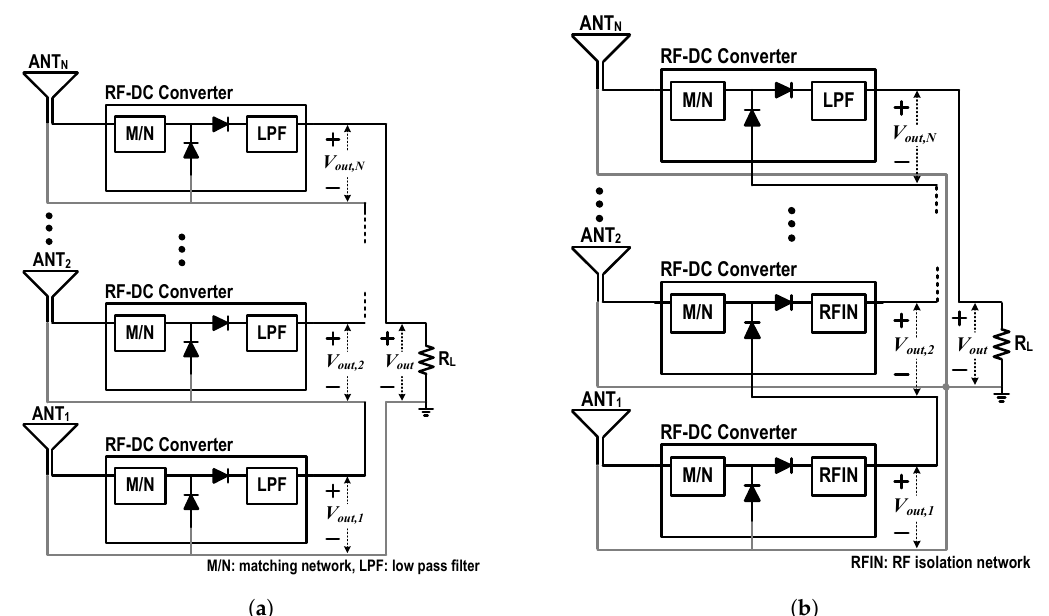
Schematics of the voltage combined N-stack RF–DC converters, ( a ) conventional and ( b )